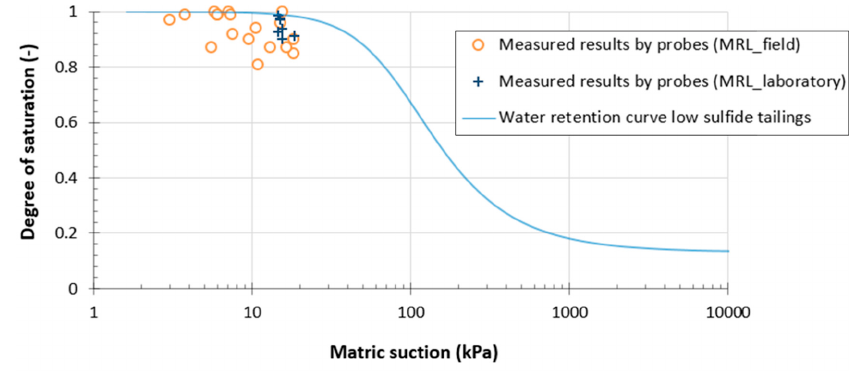
Figure 8. Degree of saturation and matric suction measured in the MRL compared to water retention curve of the low-sulfide tailings.